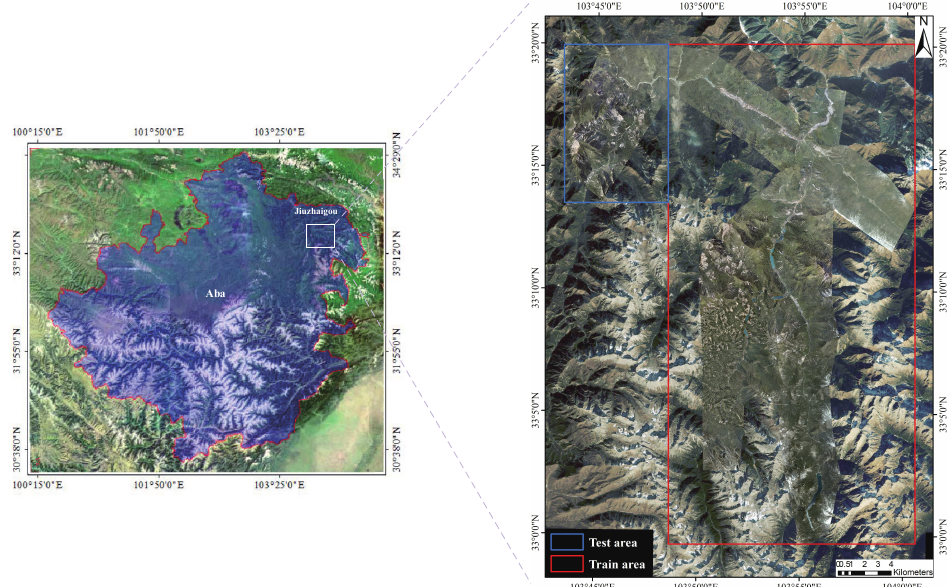
Figure 3. The study area is the Jiuzhaigou scenic spot, which was heavily damaged by the 2017 Jiuzhaigou